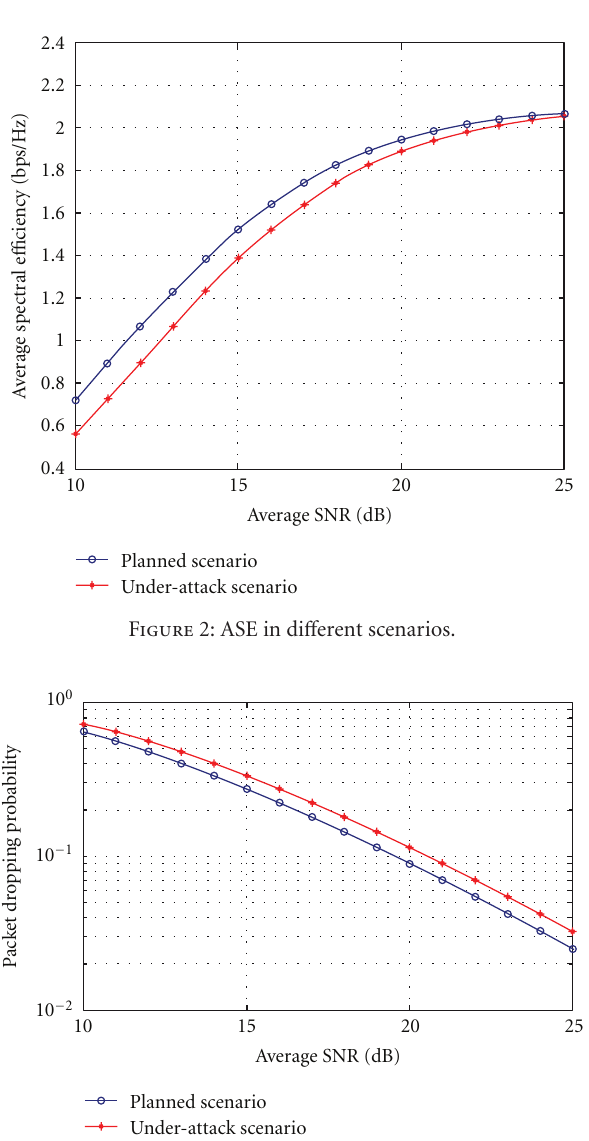
Figure 3: Packet dropping probability in di ff erent scenarios.